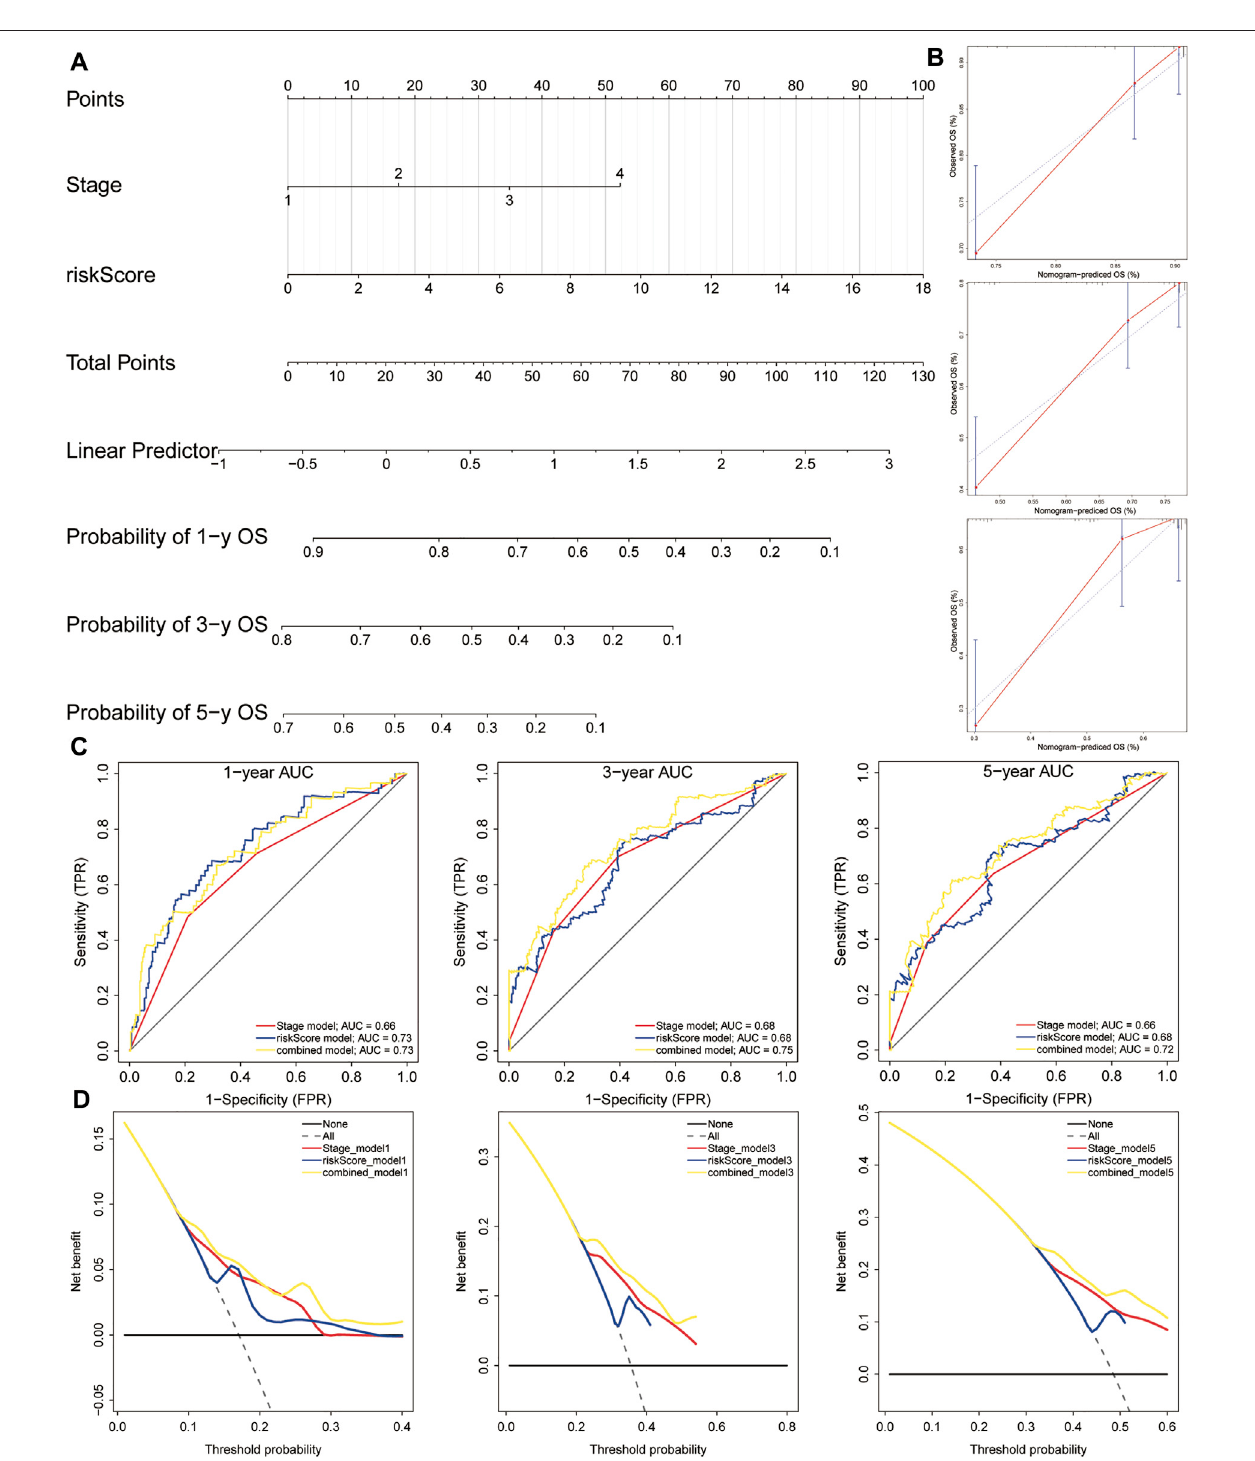
FIGURE11| Anomogram usedforsurvivalprediction. (A) Anomogram combiningthe fi ve-genesignatureandclinicalpathologicalstage. (B) Thecalibrationchart showedthatthepredicted1-,3-,and5-yearsurvivalprobabilitieswerebasicallyconsistentwithactualobservations. (C) Thet-ROCanalysisshowedthatthenomogram had good survival prediction power. (D) DCA curvevisually evaluated the clinical bene fi t ofthe nomogram and the scope ofapplication of the clinical bene fi t obtained by themodel.Thecalculatednetbene fi t( Y axis)wasplottedagainstthethresholdprobabilitiesofpatientswith1-,3-,and5-yearsurvivalonthe X axis.Thegraydotted linerepresentsthehypothesisthatallpatientshave1-year,3-year,and5-yearsurvival.Thesolidblacklinerepresentsthehypothesisthatnopatienthasa1-year,3-year, or 5-year survival period. t-ROC, time-dependent receiver operating characteristics; DCA, decision curve analysis.